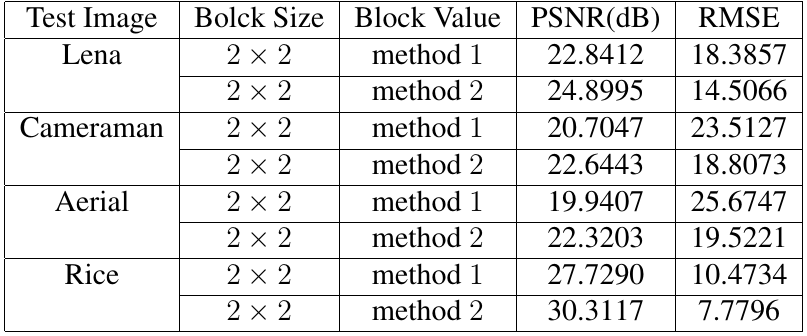
Table 1: Compression quality measures with 2 × 2 blocks using methods 1& 2